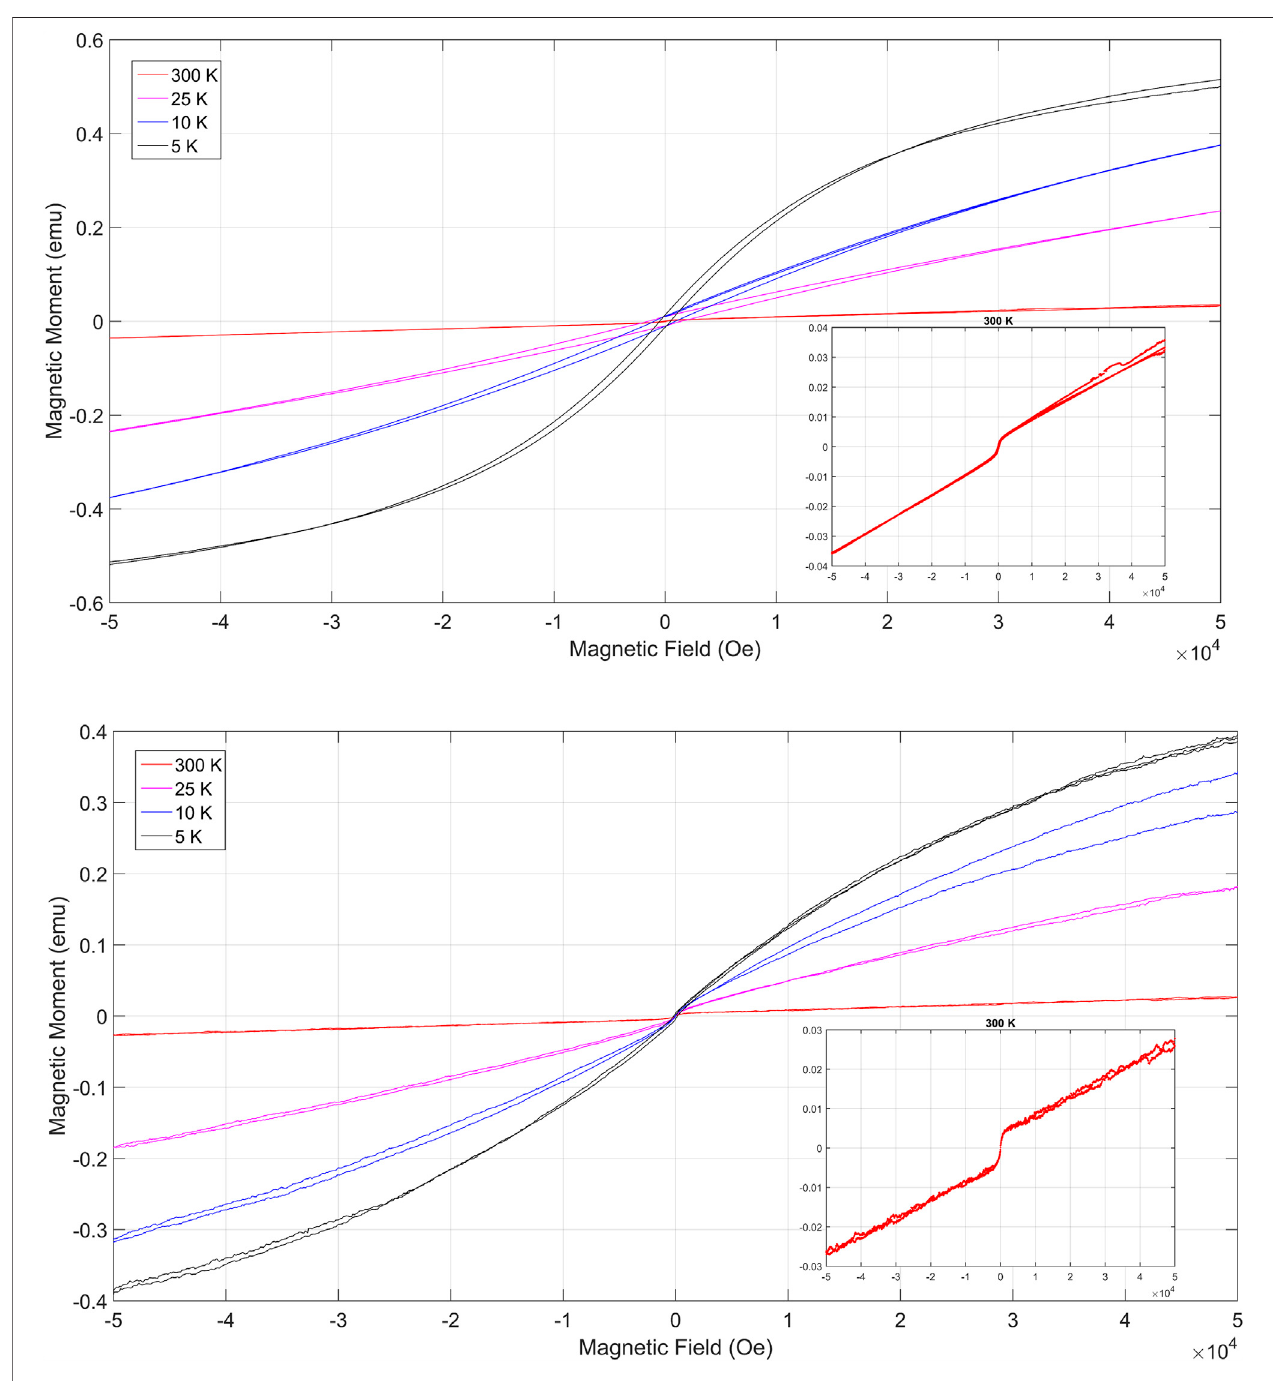
FIGURE 4 | Hysteresis cycles at distinct temperatures: (A) 2.5 m and (B) 8 m. The samples are representative of the anthropogenic deposits (A) and Quaternary sediments (B) . Inset graphs show in detail the measurements at room temperature. The ferromagnetic behavior is observed bellow room temperature. The superparamagnetic responseisobservedin (A) asasigmoidalshapeofaferromagnetic responsewithnoloop.This fi ngerprintisnotvisibleinthehysteresiscyclein (B) .